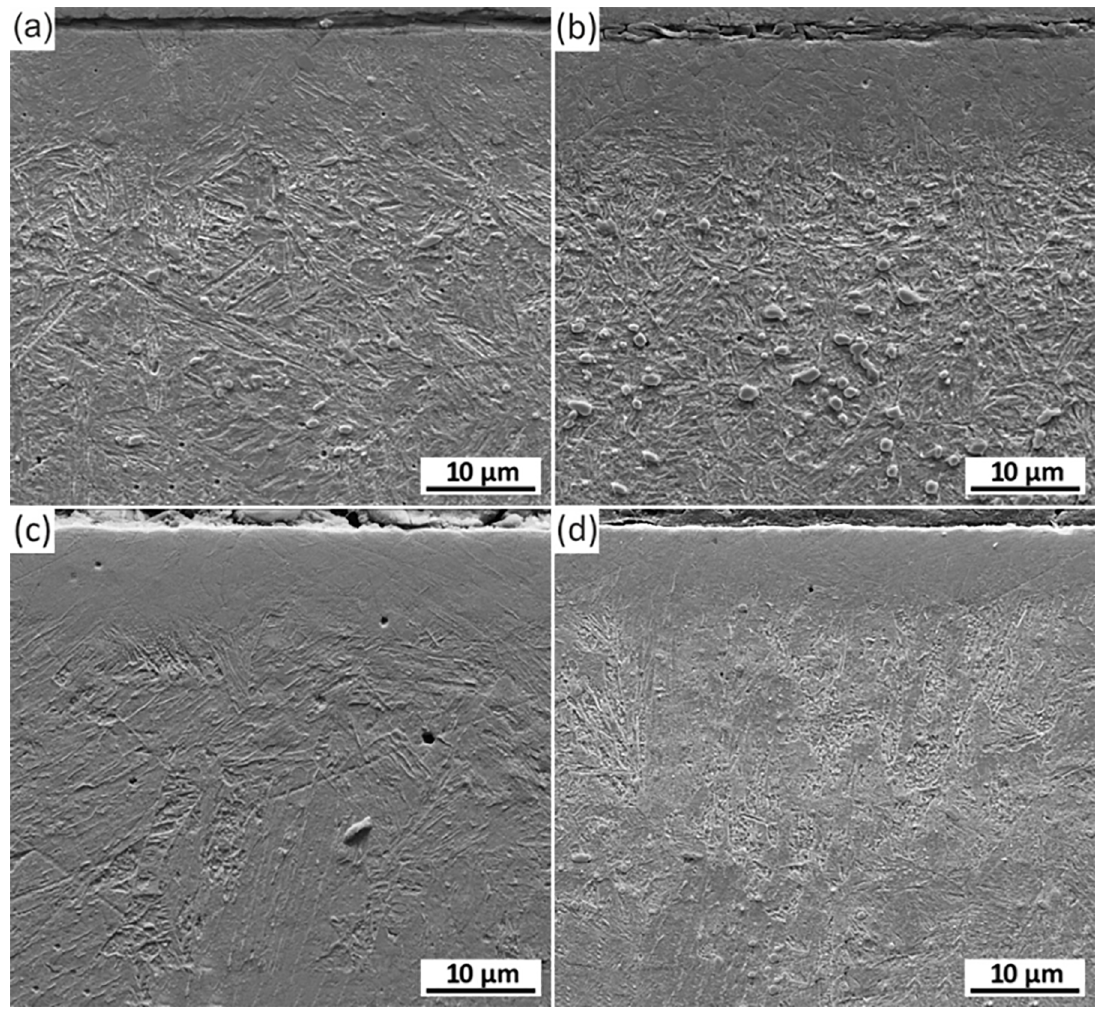
Figure 1. SEM images of nitrided layers for the samples, which were nitrided in different conditions. (a) N1, (b) N3, (c) N2, (d) N4.